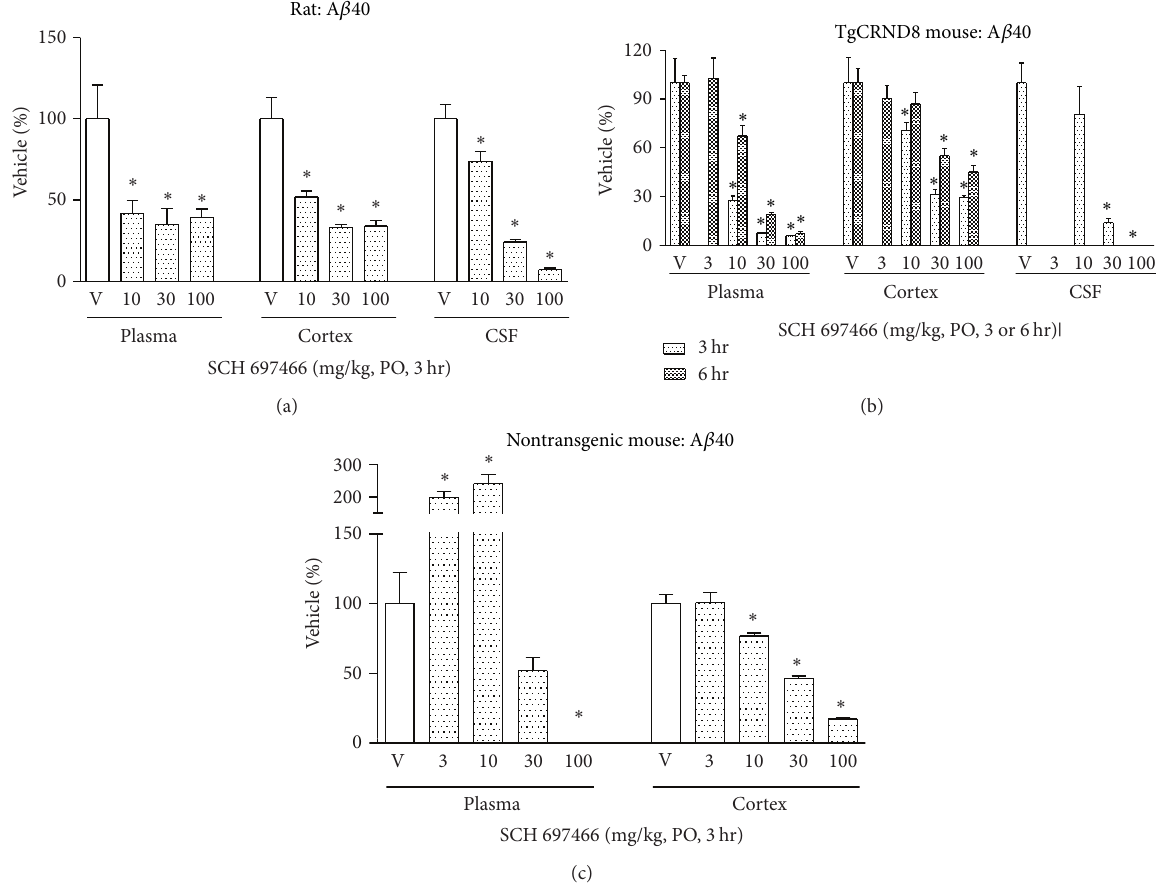
Figure 2: A 𝛽 40 levels expressed as a percent of vehicle in plasma, cortex, and CSF following acute administration of SCH 697466 to (a) rats, (b) TgCRND8 mice, and (c) nontransgenic B6C3F1 mice. For the TgCRND8 studies (b) CSF was not collected in the 6 hr study and 3 mg/kg SCH 697466 was not included in the 3hr study. ∗ 𝑃 < 0.02 versus vehicle, Dunnett post hoc test.